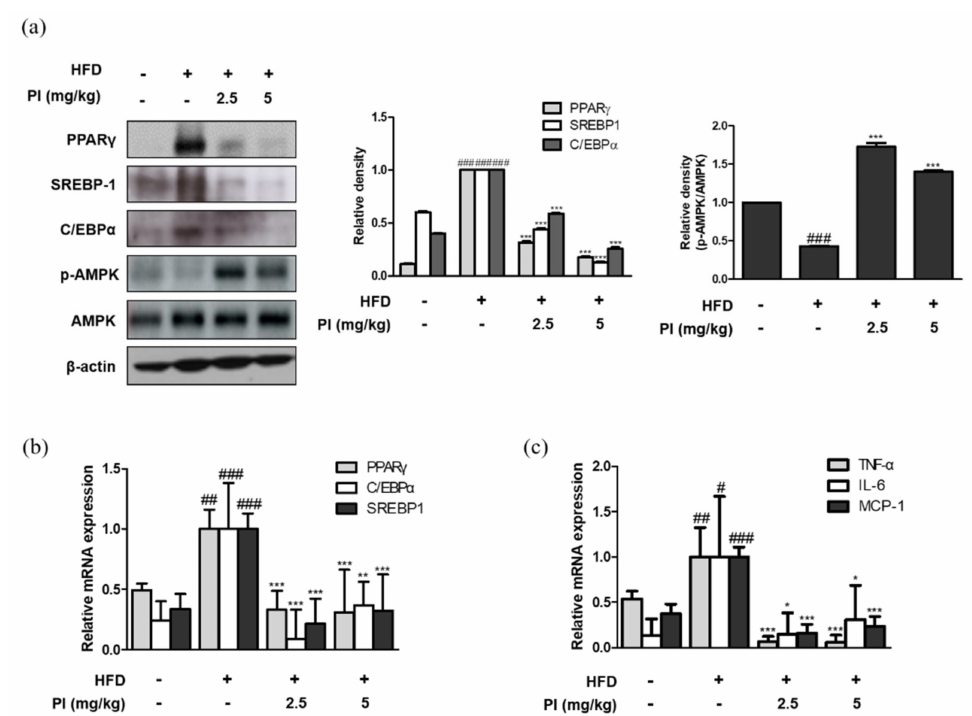
Figure 3. Effects of papain on adipogenic factors and inflammatory markers in liver of HFD–induced obese mice. ( a ) Protein expressions of PPAR γ , SREBP–1, C/EBP α , p–AMPK and AMPK were determined by western blot analysis with specific antibodies. β -actin was used as internal controls. ( b ) The mRNA levels of PPAR γ , SREBP–1, and C/EBP α were determined by qRT–PCR. ( c ) The mRNA levels of TNF– α , IL–6, and MCP–1 were determined by qRT–PCR. Densitometric analysis was performed using Bio-Rad Quantity One ® Software. The data shown represent mean ± SD of three independent experiments. # p < 0.05, ## p < 0.01, ### p < 0.001 vs. ND group; * p < 0.05, ** p < 0.01 and *** p < 0.001 vs. HFD